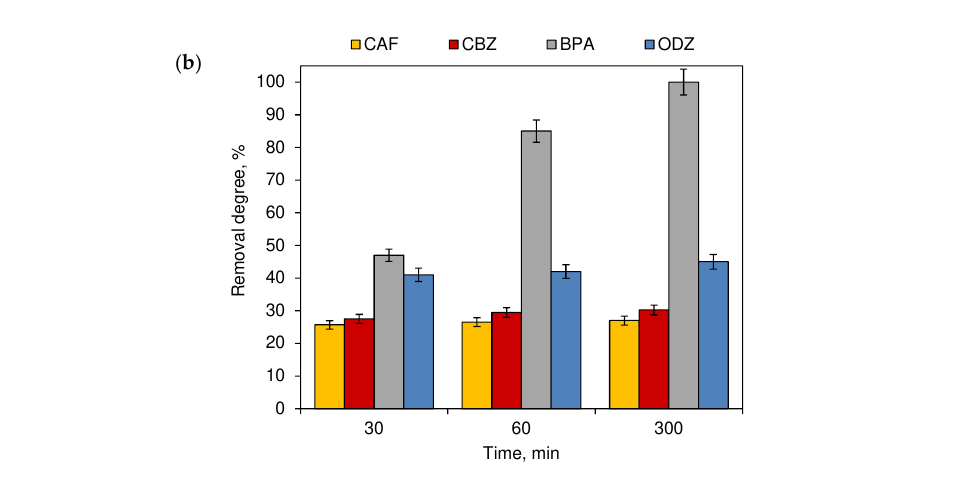
Figure 8. The removal degree of CECs from chlorinated model swimming pool water additionally disinfected by O 3 light—( a ) outdoor swimming pool and ( b ) indoor swimming pool ( n = 3; where CAF—caffeine, CBZ—carbamazepine, BPA—bisphenol A, ODZ—oxadiazon). Table 2. Occurrence of by-products in the post-processed water